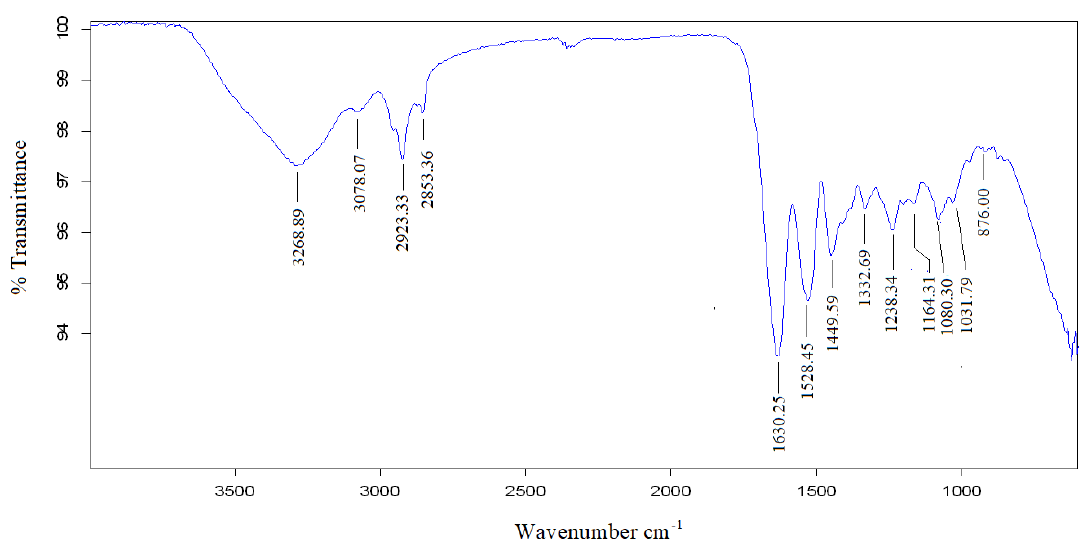
Figure 3. FTIR spectrum for ABs before adsorption of oil.